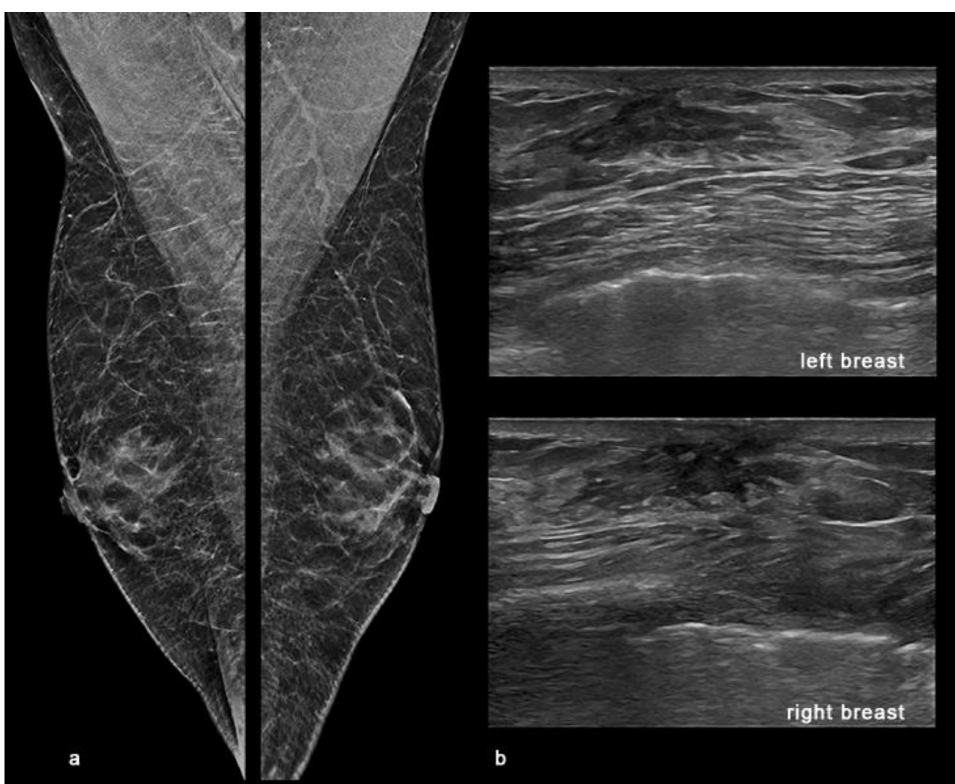
Figure 7. Gynaecomastia. Digital breast tomosynthesis (DBT) and ultrasound (US) showing bilateral gynaecomastia in a 74-year-old male observed at our department with tender lumps in both breasts and mastodynia at clinical examination. ( a ) The synthetic 2D reconstructed medio-lateral-oblique images (s2D-MLO) showed a symmetric increased flame-shaped sub-areolar density in both breasts. ( b ) US showed a retro-areolar, triangular, hypoechoic mass in both